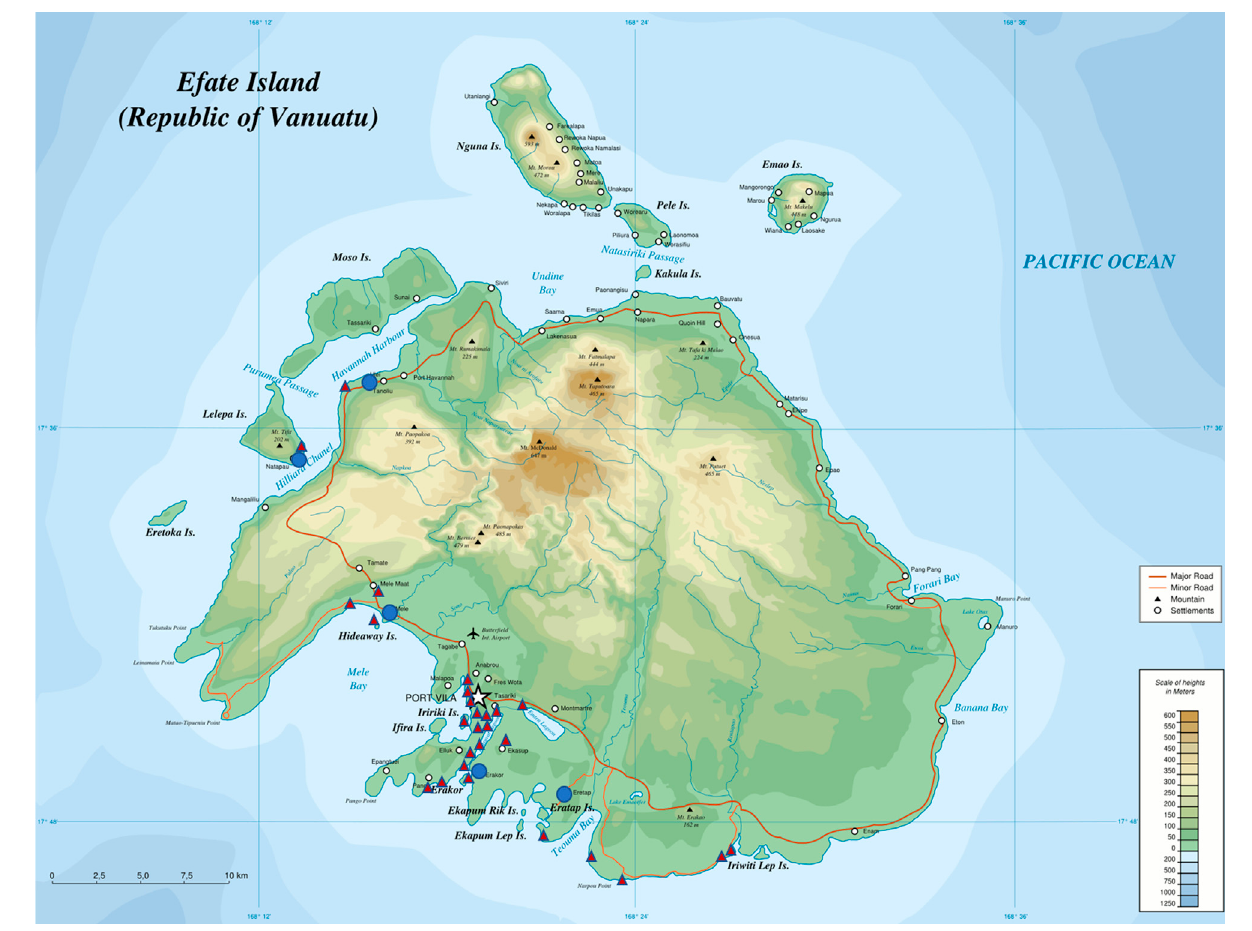
FIGURE4| MapofEfateIslandwithlocationsofhotelsandtouroperations(purpletriangles)andcommunities(bluecircles)selectedforthestudy.Source:Adapted from https://commons.wikimedia.org/wiki/File:Map_of_Efate_Island_EN.png